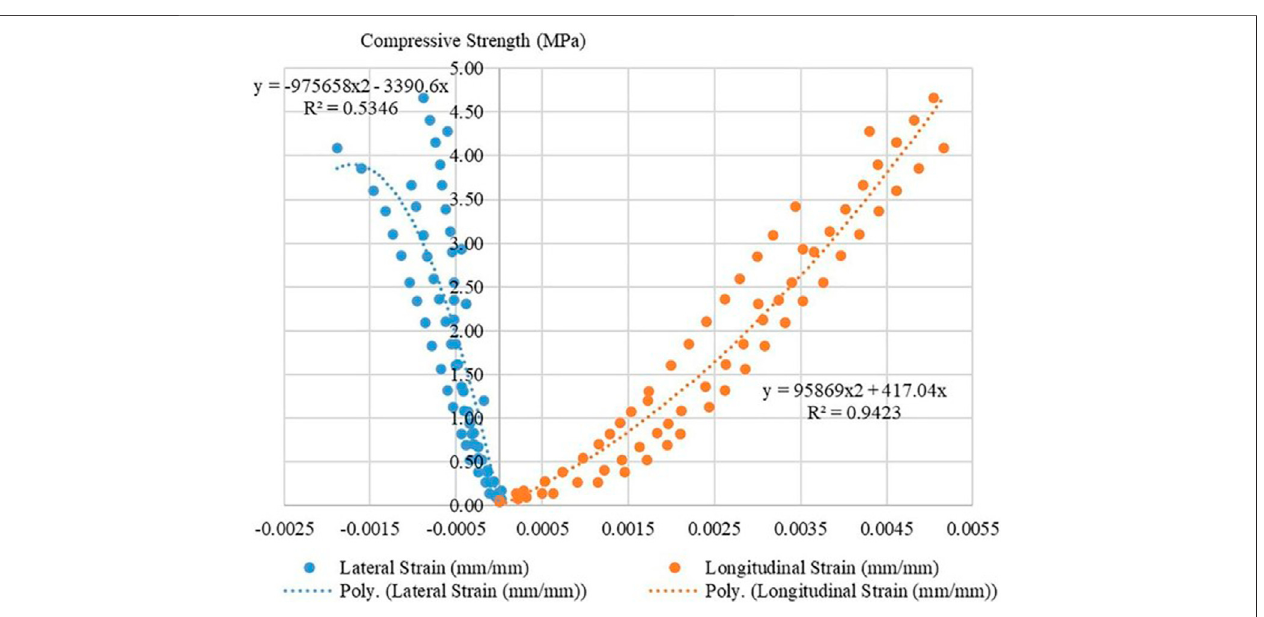
FIGURE 8 | Compressive toughness of LFC-CTW0 at 56 days ’ curing age.